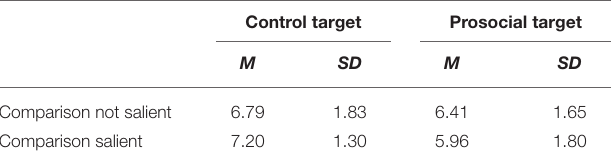
TABLE 1 | Mean target likeability ratings per condition in Experiment